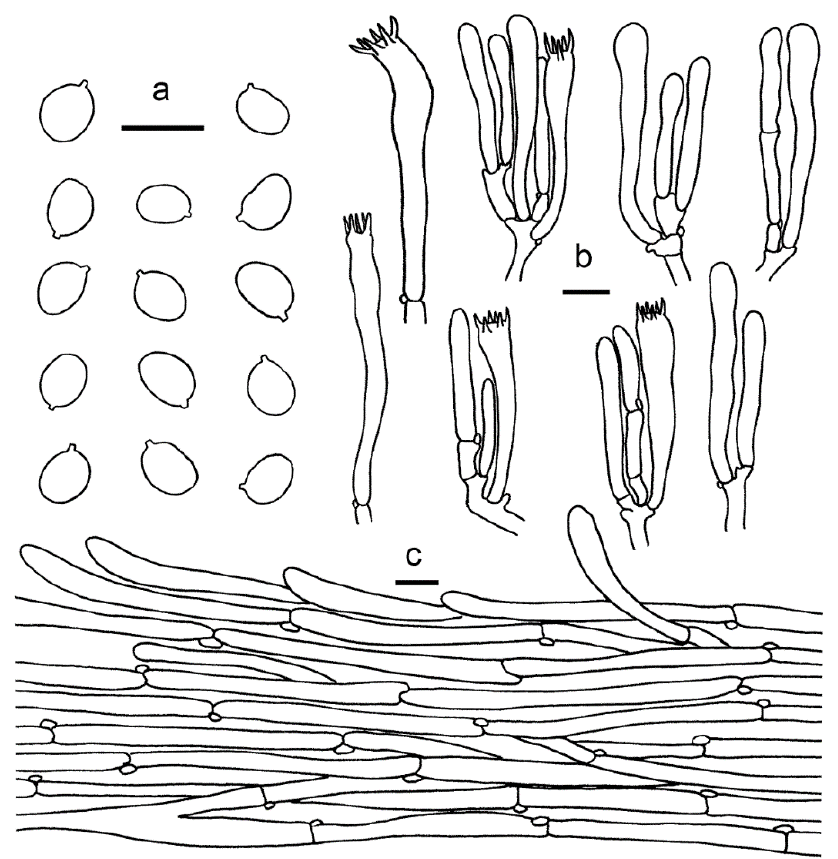
Figure 8. Cantharellus galbanus (GDGM86249, Holotype!). ( a ) Basidiospores. ( b ) Basidia, basidiola and elements of the subhymenium. ( c ) Pileipellis. Bars: ( a , b ) = 10 μ m; ( c ) = 20 μ m.